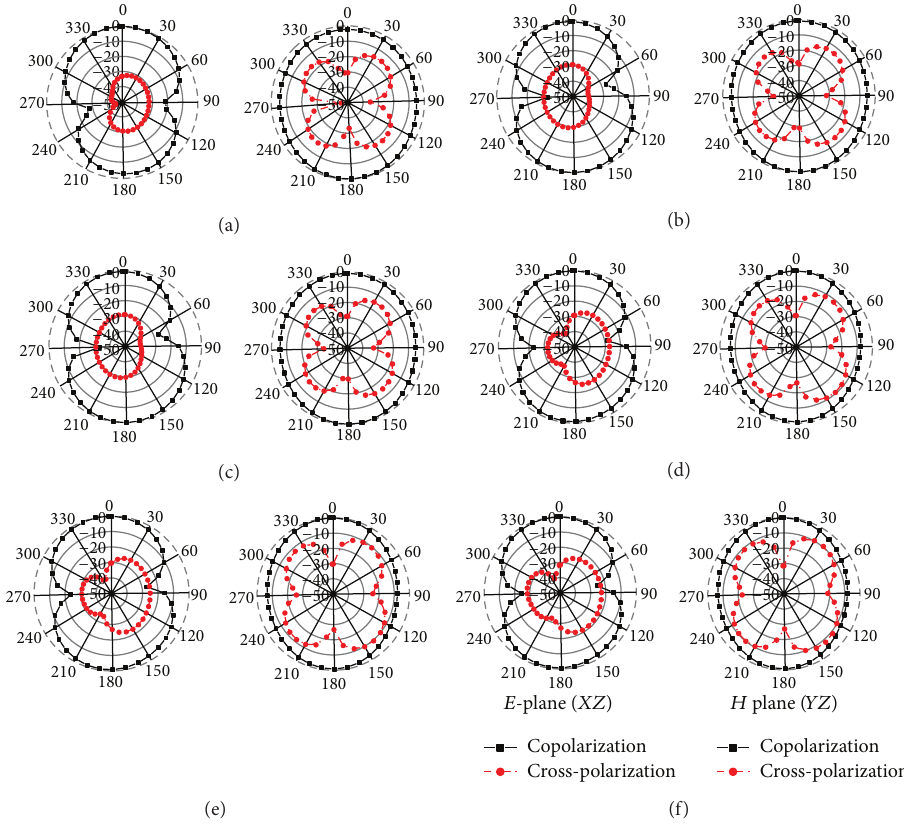
Figure 17: Radiation pattern of the proposed antenna at (a) 3.20 GHz, (b) 3.50 GHz, (c) 3.70 GHz, (d) 5.2 GHz, (e) 5.5 GHz, and (f) 5.8 GHz.